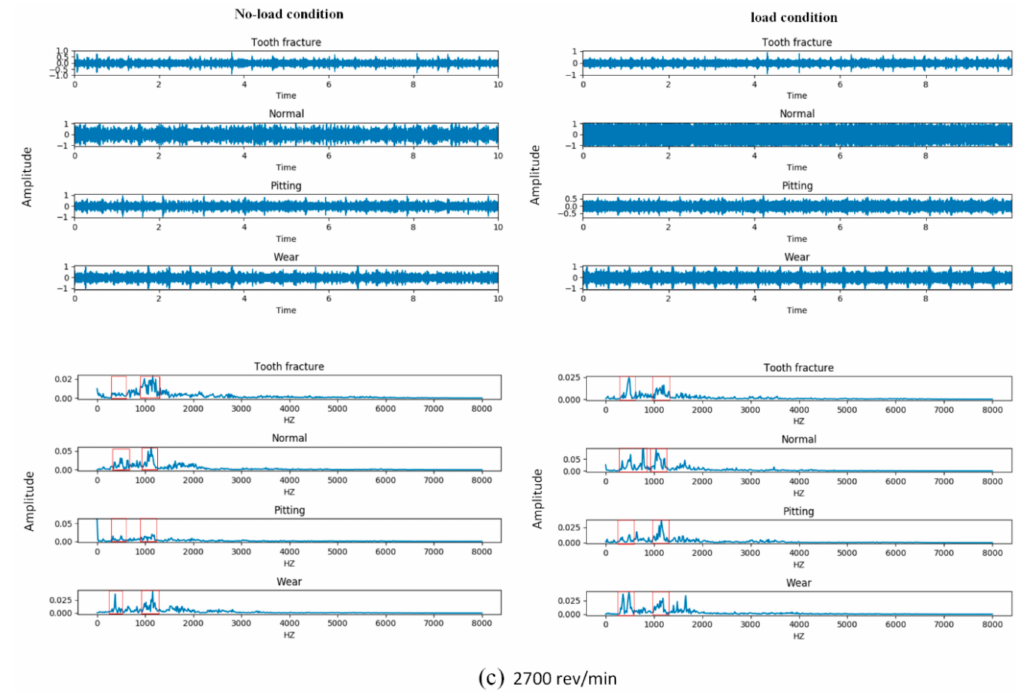
Figure 7. Four di ff erent types of gear signals in the time and frequency domains under two load conditions: ( a ) signal at 900 rev / min, ( b ) signal at 1800 rev / min, and ( c ) signal at 2700 rev /